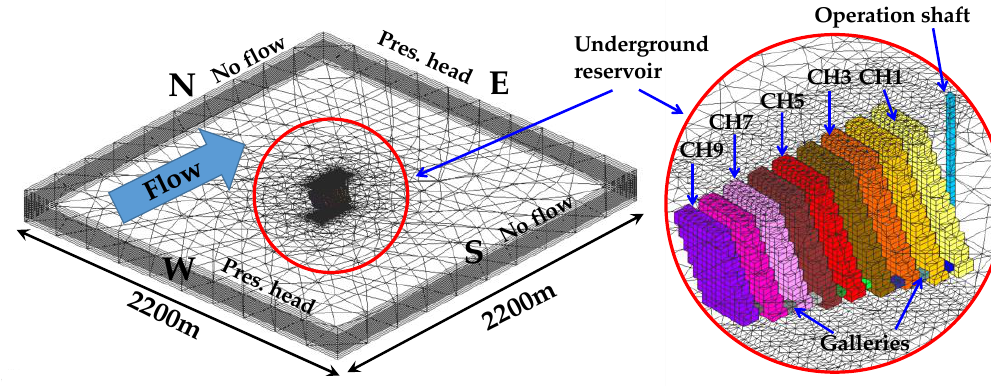
Figure 3. General view of the numerical model (left) and detailed view of the modelled chambers and 212 operation shaft (right). The bottom of the chambers increases from 110 to 150 m depth in the flow 213 direction. 214